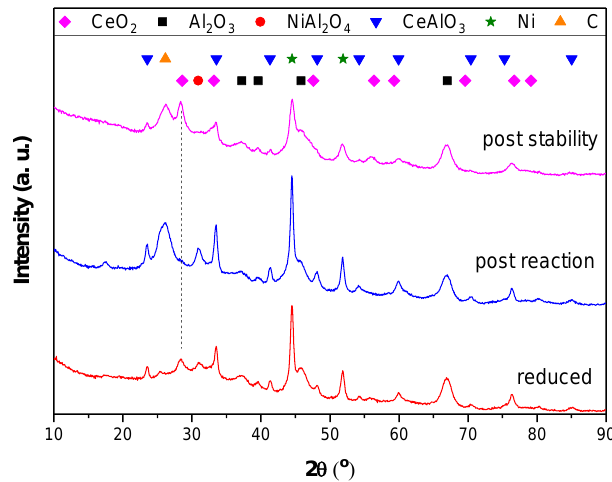
Figure 9. XRD characterisation spectra for Ni-Sn/CeAl reduced, post reaction and post stability at a CH 4 /CO 2 molar ratio of 1.5.